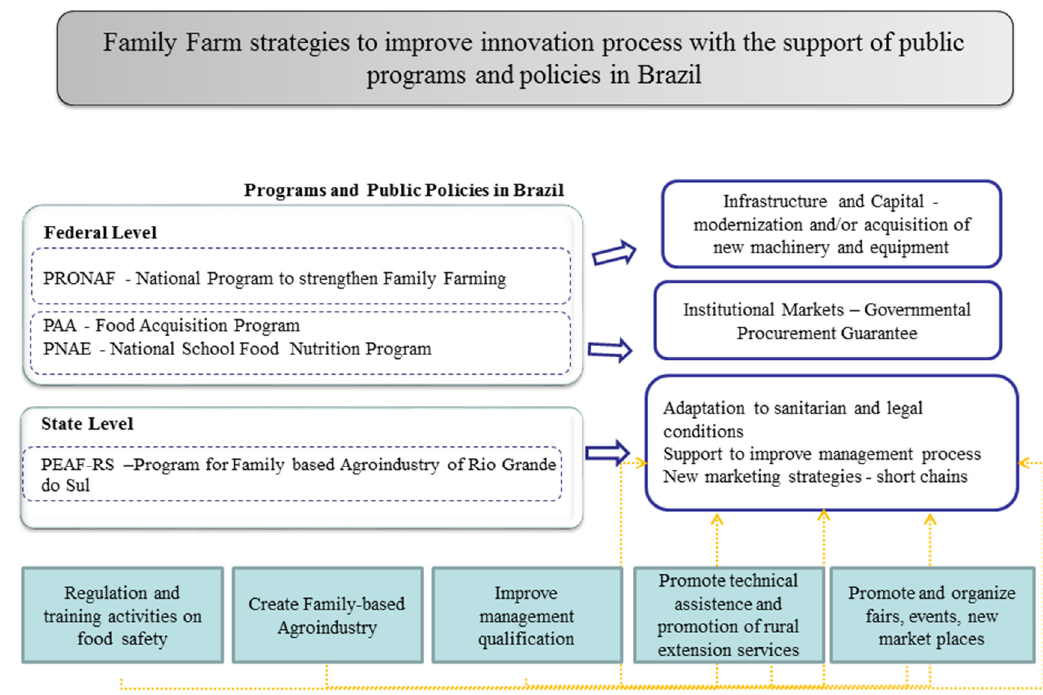
Figure 2. State programs: Support for small-scale farmers and public food procurement.